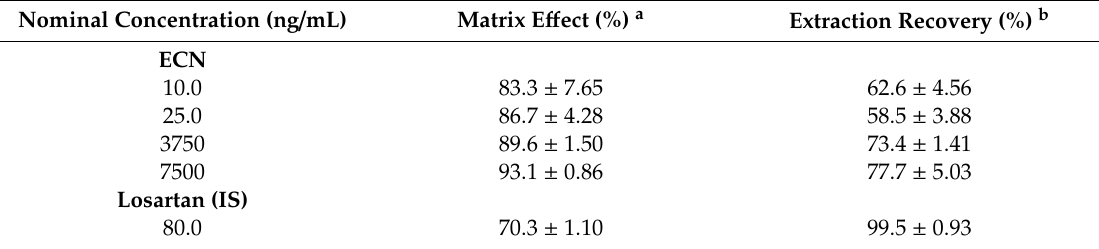
Table 2. Matrix e ff ect and extraction recovery of